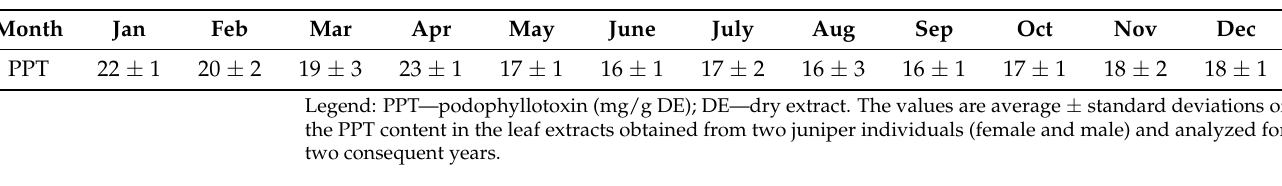
Table 9. Seasonal stability of the PPT content in J. virginiana leaf